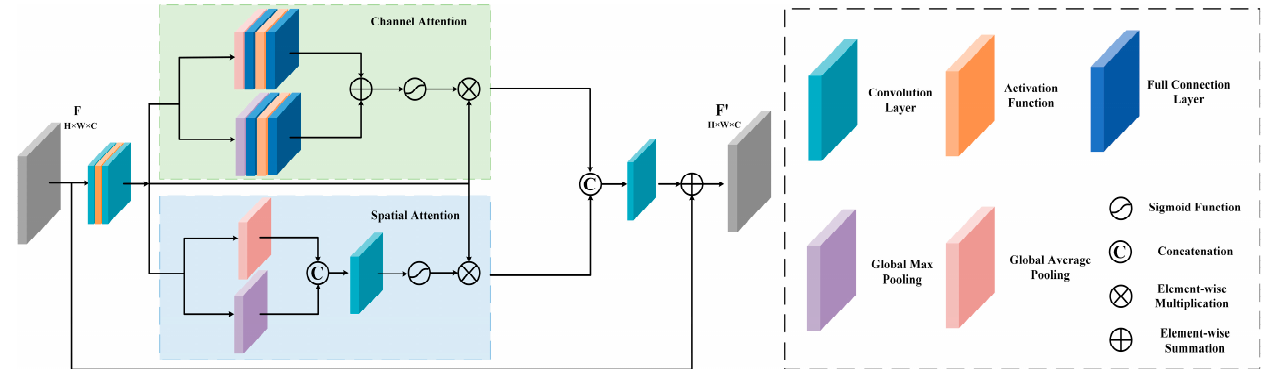
Figure 5. Dual attention module incorporating spatial and channel attention mechanisms in the residual block.